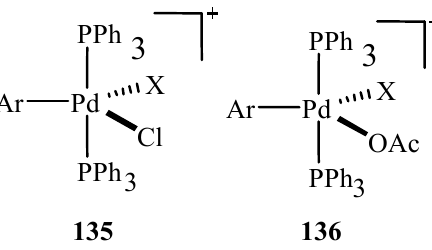
Figure 19. Intermediate anionic pentacoordinated arylpalladium(II) complexes formed in Heck reaction.